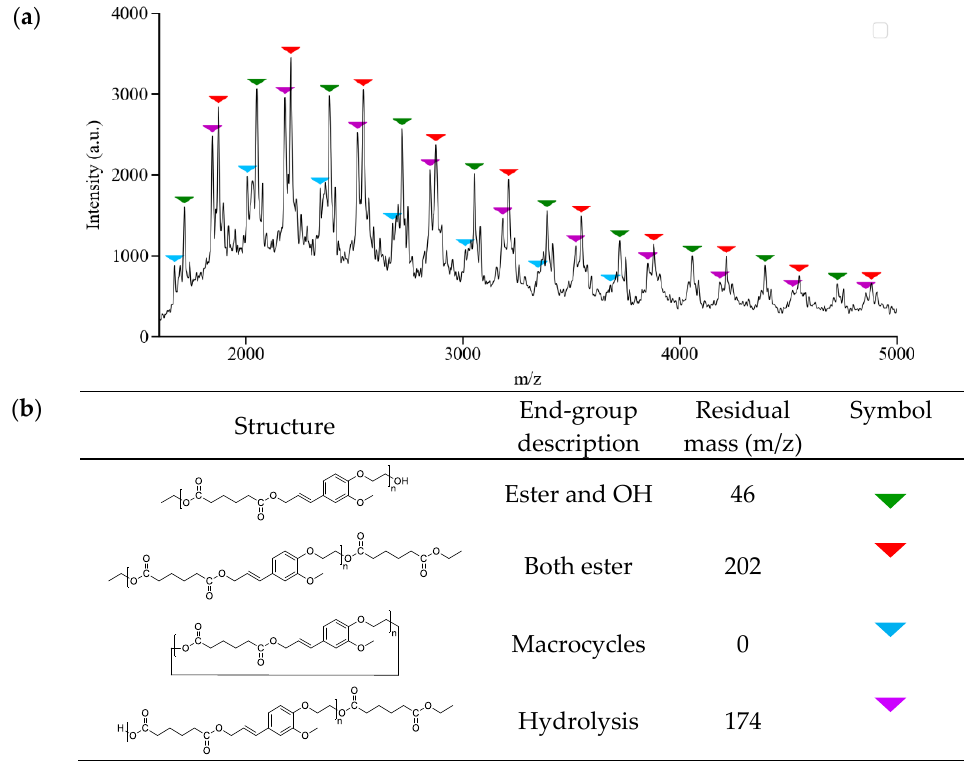
Figure 5. ( a ) MALDI-TOF MS spectrum of 7a ; ( b ) corresponding identified polymer structures.